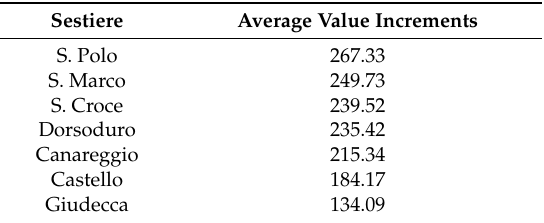
Figure 9. Average value increments of eliminating high water for upper stories. Value increments were higher in the Sestieri of S. Polo, S. Marco, S. Croce, and Dorsoduro, whereas minor increments were registered in Castello and Giudecca due to lower real estate value.